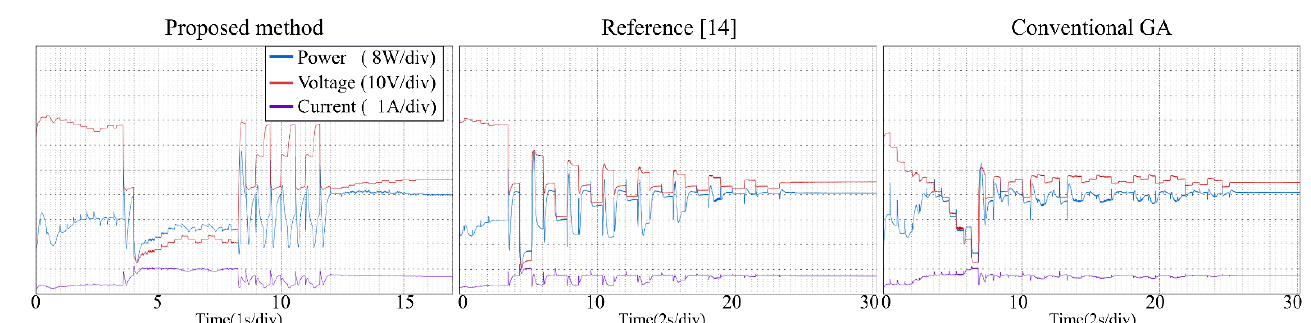
Figure 15. Tracking process—Pattern 3.